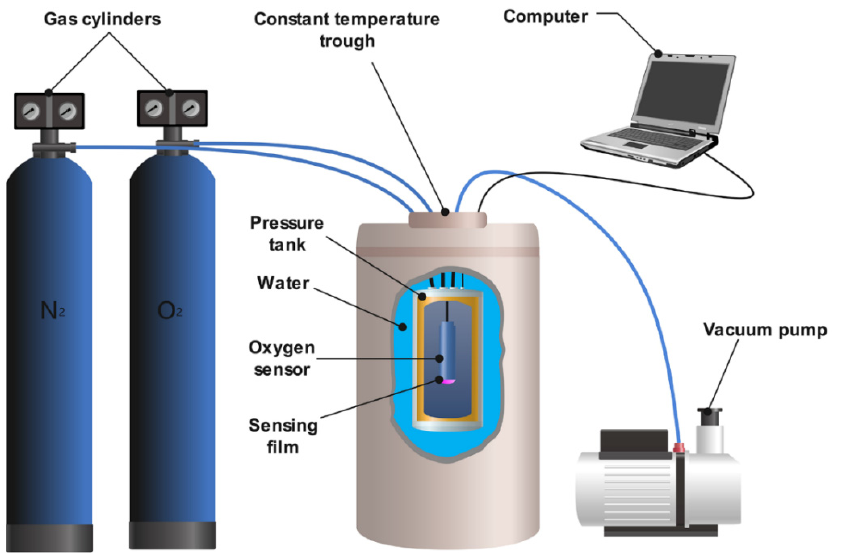
Figure 2. Schematic diagram of the experimental apparatus used to test the performance of the sensing film.